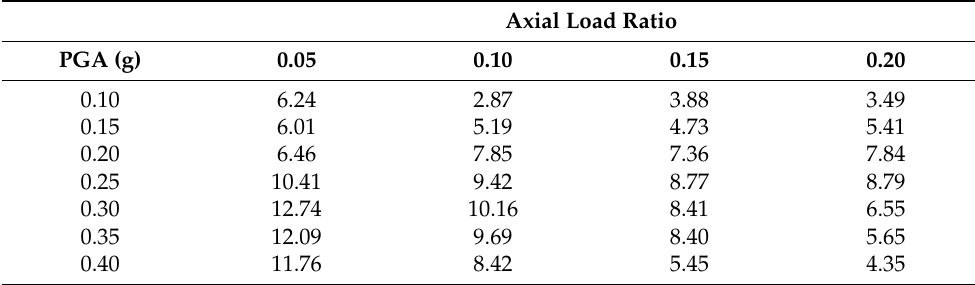
Table 4. Maximum damage growth rate